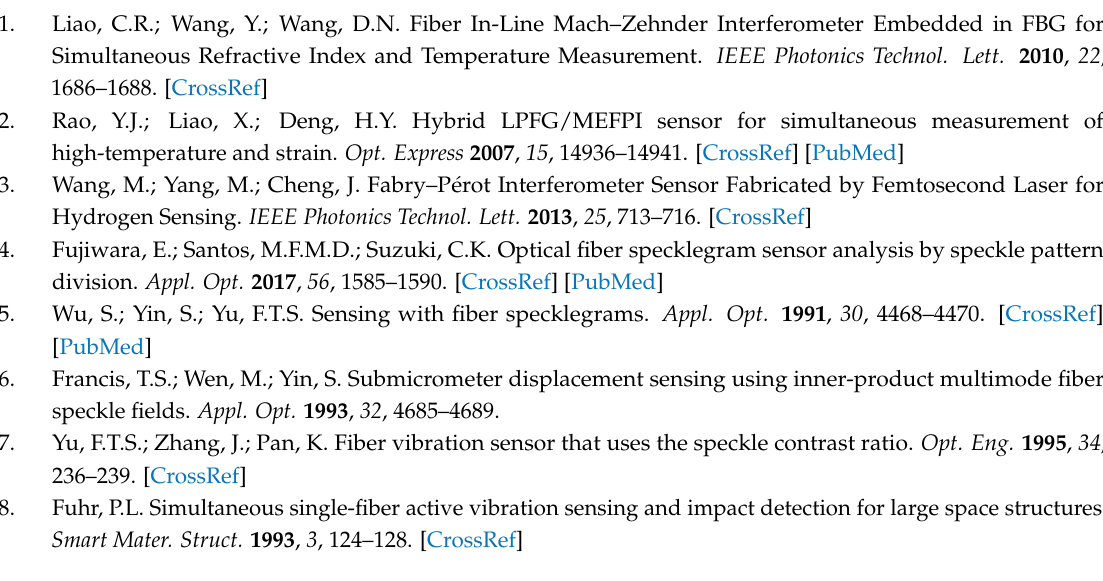
Figure 8. Pressure response under different degrees of reduction.